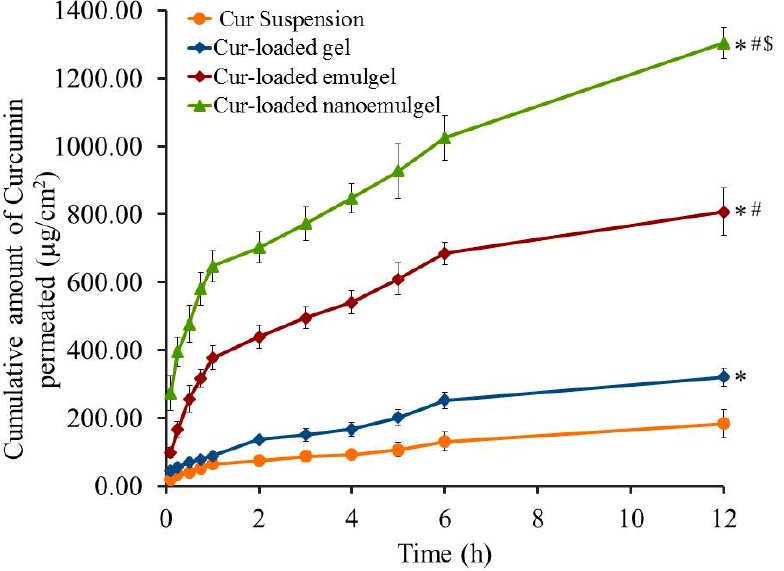
Figure 6. Permeation profiles of Cur across rat skin from different Cur-loaded formulations compared to Cur aqueous suspension (control). Results are expressed as mean ± SD (n = 3). * p < 0.05 compared to Cur aqueous suspension. # p < 0.05 compared to Cur-loaded gel. $ p < 0.05 compared to Cur-loaded emulgel. Table 6. Ex vivo skin permeation parameters (SSTF and ER) of different Cur-loaded formulations. Formula